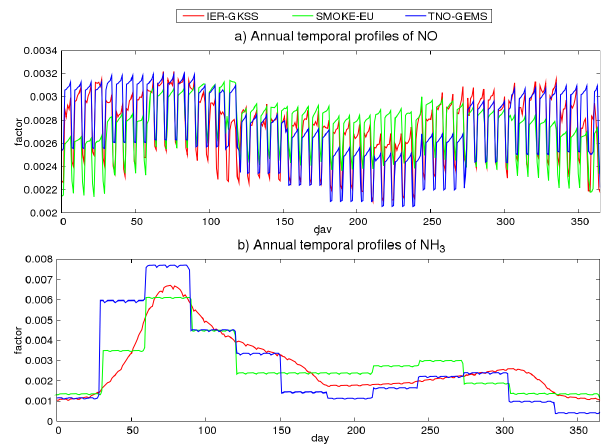
Fig. 9. (a) Spatial average annual NH 3 emissions of different emission datasets for the year 2000. (b) Variograms for NH 3 of different emission datasets for the year 2000. All values are for concentric circles with 100km distance on a 54 × 54km 2 domain (Fig. 2).